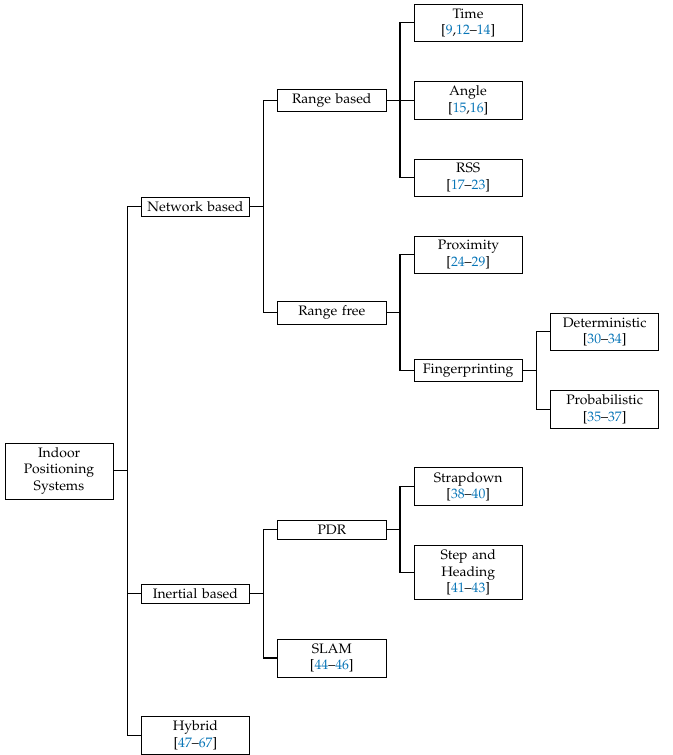
Figure 1. Classification of Indoor Positioning Systems. Time [9,12–14], Angle [15,16], RSS